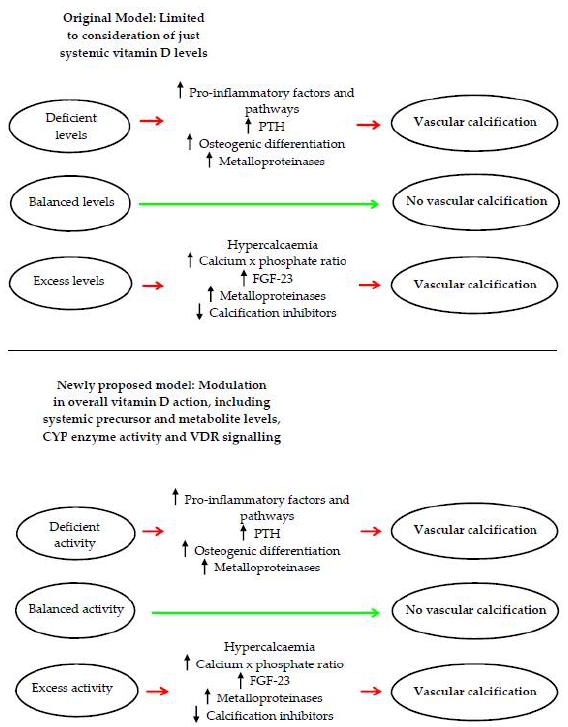
Figure 1. Schematic comparing the original and newly proposed models behind vitamin D’s biphasic response on vascular calcification. (Top panel): Original model concerning that perturbation of systemic vitamin D levels determine calcification outcomes; (Bottom panel): Newly proposed model that perturbation of overall vitamin D activity, comprising systemic levels, as well as vitamin D turnover and VDR signalling activity, collectively contribute to VC. FGF-23: fibroblast growth factor 23; PTH: parathyroid hormone.